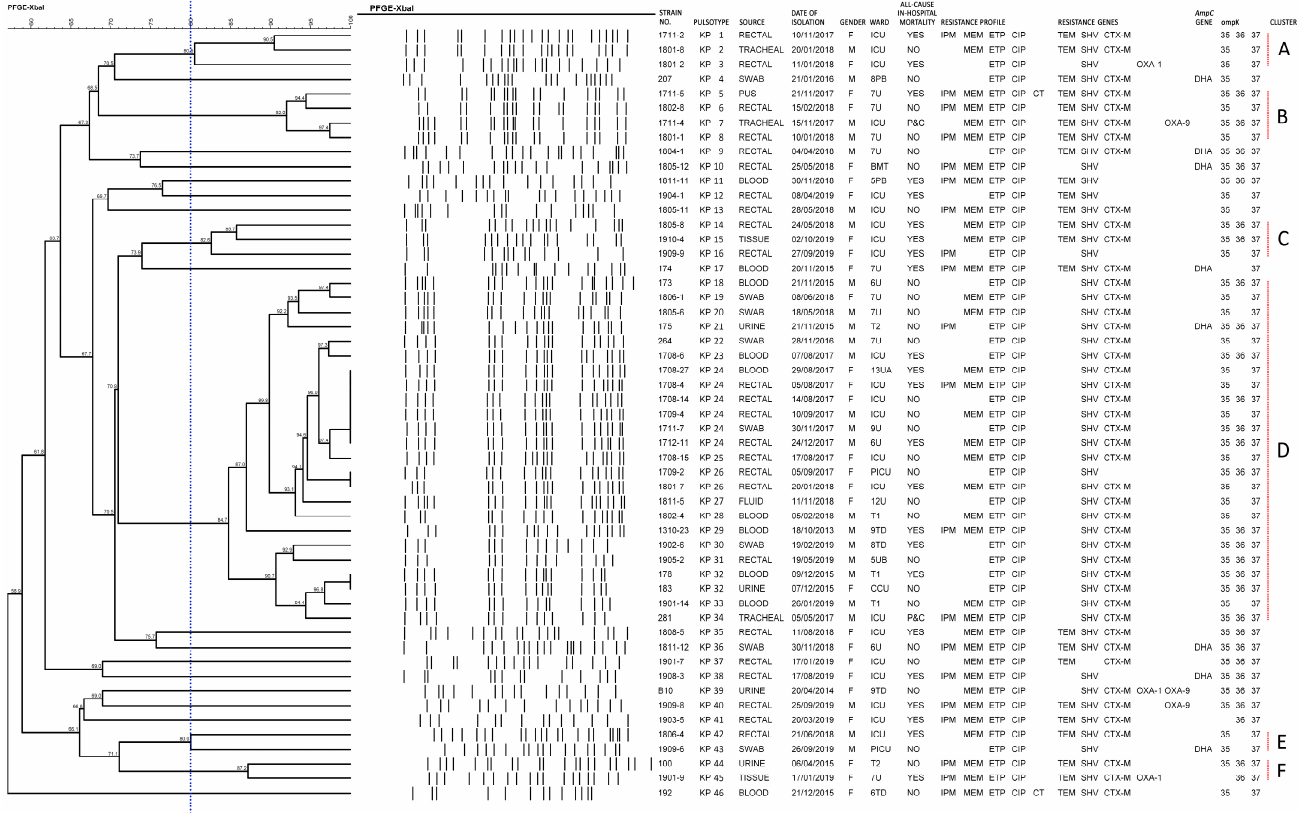
Figure 2. Dendrogram of 53 strains. Gender: Female (F) or male (M). Resistance profile: Imipenem (IPM), meropenem (MEM), ertapenem (ETP), ciprofloxacin (CIP), and/or colistin (CT). Presence of AmpC β -lactamase gene: bla DHA. Presence of other non-carbapenemase β -lactamase genes: bla TEM , bla SHV , bla CTX-M , bla OXA-1 , and/or bla OXA-9. Presence of porin-associated genes: ompK35 , ompK36 , and/or ompK37 . Pulsotype: Strains that exhibited 100.0% similarity. Cluster: Pulsotypes that had 80.0% sim- ilarity. “P&C” is an abbreviation for private and confidential.